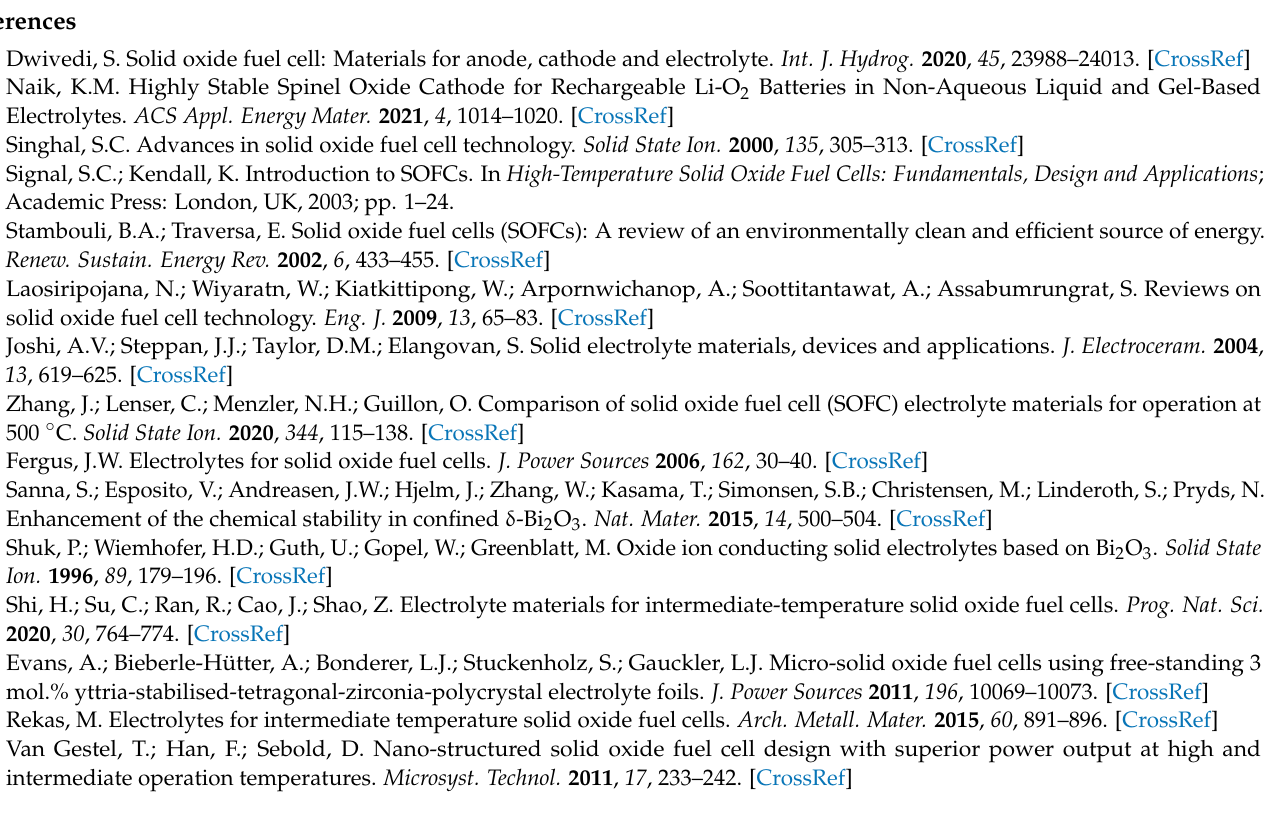
Figure 4S: Mean size in samples sintered for 2 h in air at 1773 K as a function of alumina content: (a) grains of the 3Y-TZP matrix and (b) Al 2 O 3 inclusions; Table S1: Temperature ranges associated with expansion and shrinkage, as determined for two series of powders after 1 h of calcination in air at 873 K. Table S2: Activation energy of conduction with respect to total conductivity (E a(tot) ) as well as grain interior (E a(b) ) and specific grain boundary conductivity (E a(sp.gb) ), as calculated for the studied 3Y-TZP and 3Y-TZP/Al 2 O 3 samples obtained after 2 h of sintering in air at 1773 K. Refs [68–72] are cited in the